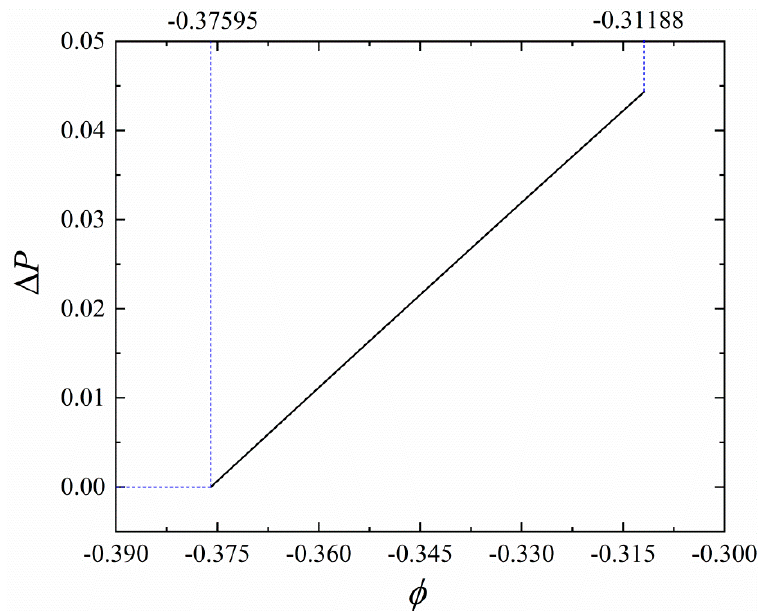
Figure 2. The relationship between the pressure difference Δ P (defined in Equation (13)) and ϕ at ε = − 0.3, where the density ϕ ranges from − 0.37595 to − 0.31188 corresponds and to the parameters of the undercooled liquid phase.